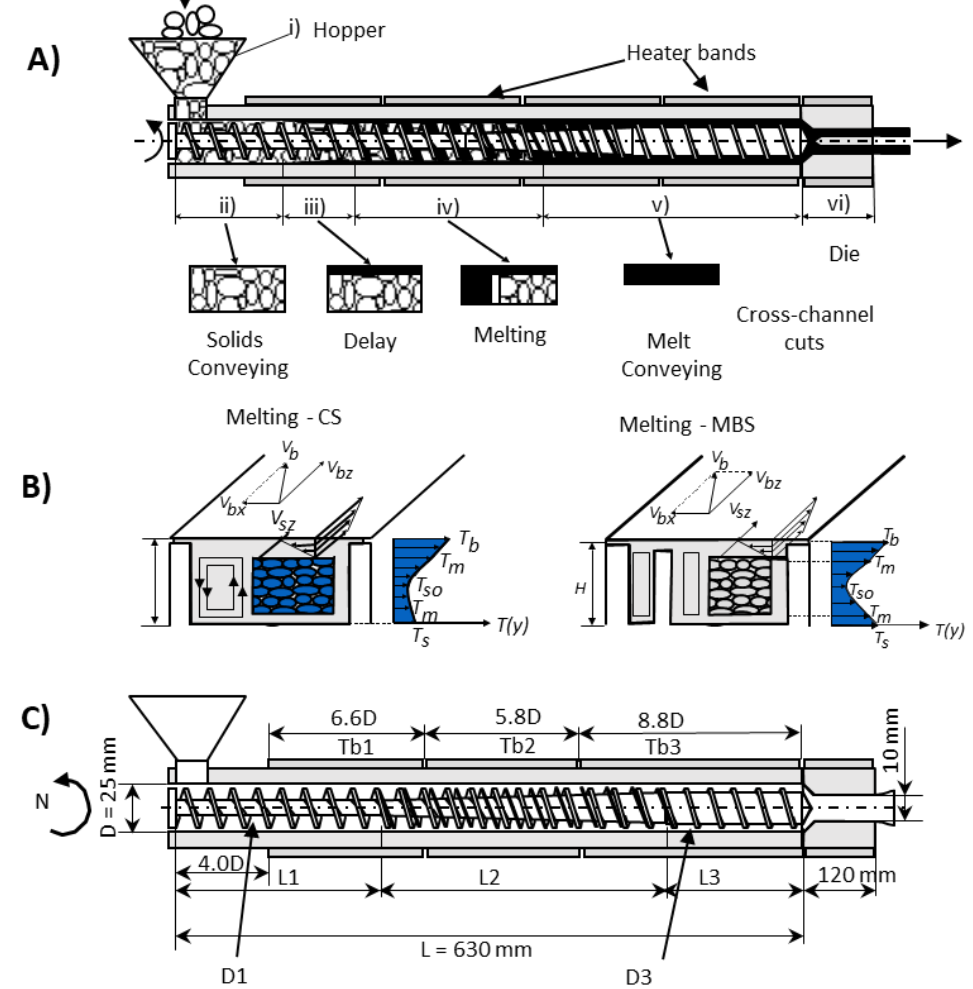
Figure 7. Single screw extrusion: ( A ) plasticating phases; ( B ) melting mechanism in CS (left) and MBS (right); ( C ) specific system geometry used in the